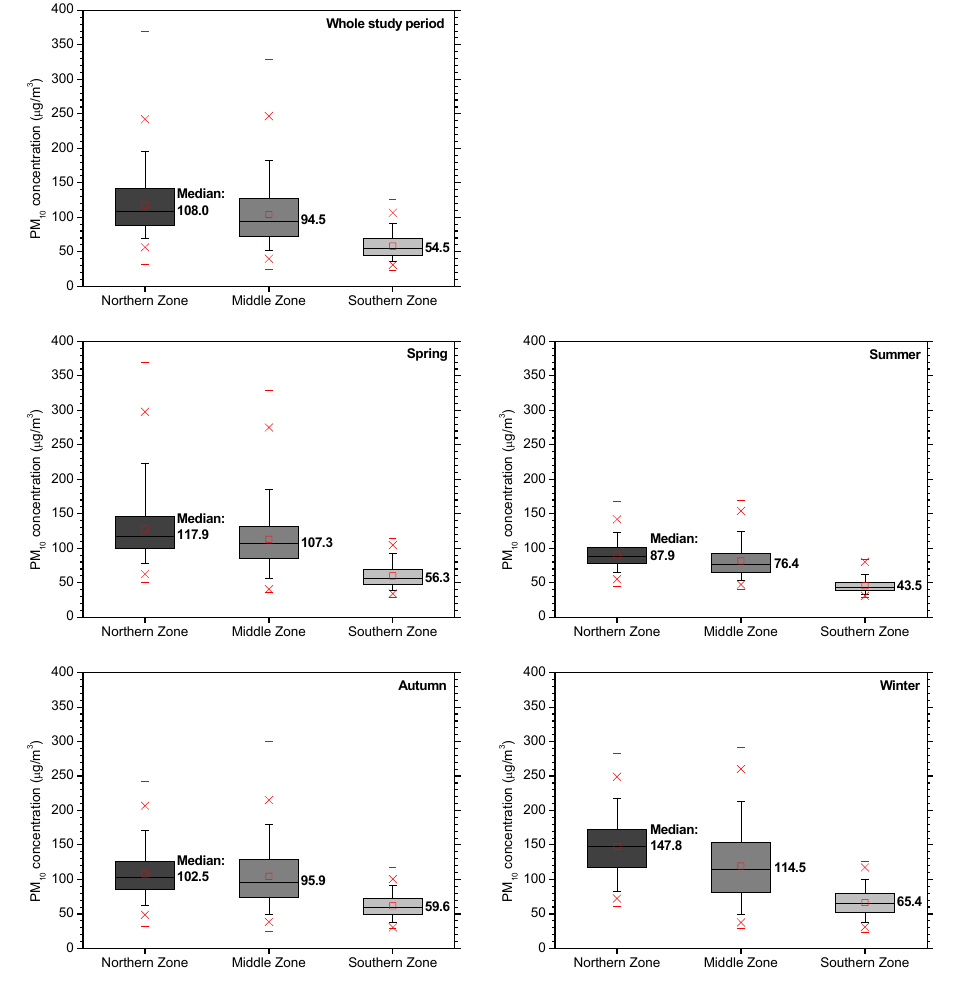
Fig. 6. Comparison of PM 10 levels and variations for the three latitudinal zones in different seasons: the box-and-stem plots depict the minimum, the 1th, 5th, 25th, 50th (median), 75th, 95th, 99th percentile and the maximum for the PM 10 concentration, the red square in the box depicts the arithmetic mean PM 10 concentration, the median PM 10 concentrations are also